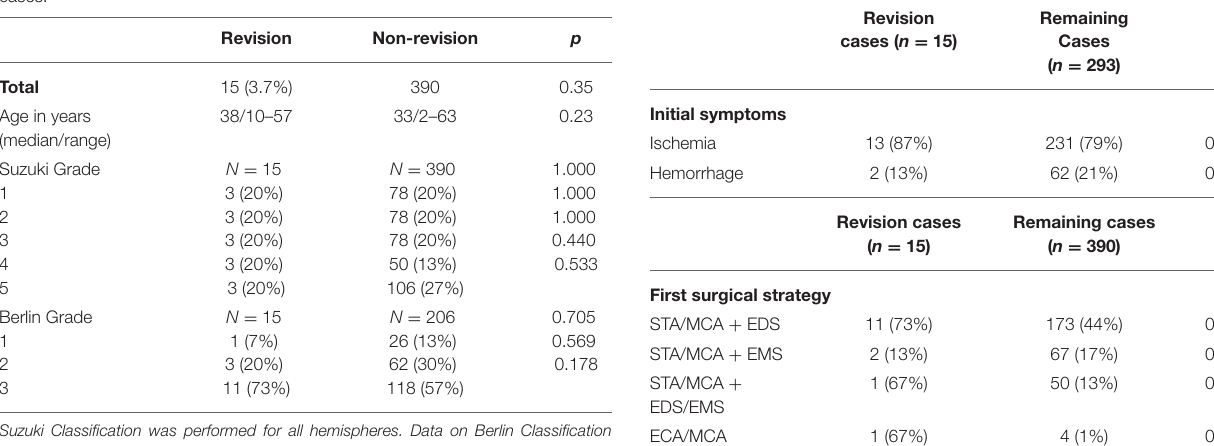
TABLE 2 | Initial symptoms and surgical strategies for initial